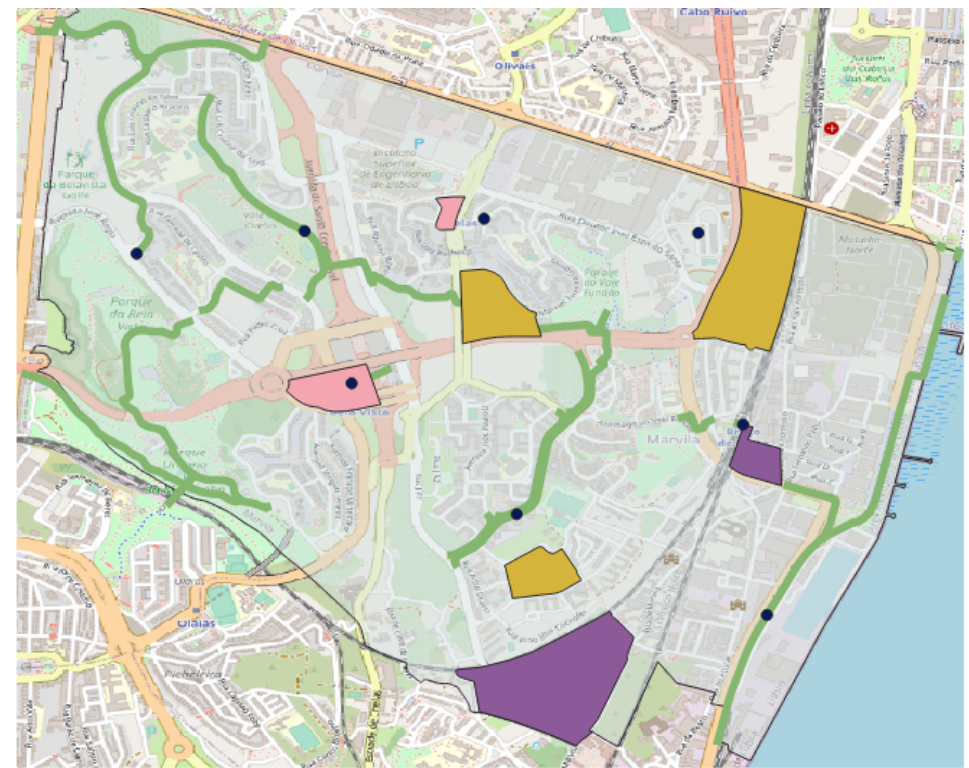
Figure 19. Bike-sharing docking stations prediction for Marvila. Dark blue dots represent the optimised locations for K-Means outputs (docking stations over bike paths). Subway has the pink colour polygon while the purple polygon regards the train station. Schools are coloured yellow and bike lanes green.Background map source: OpenStreetMap [46]. Source: